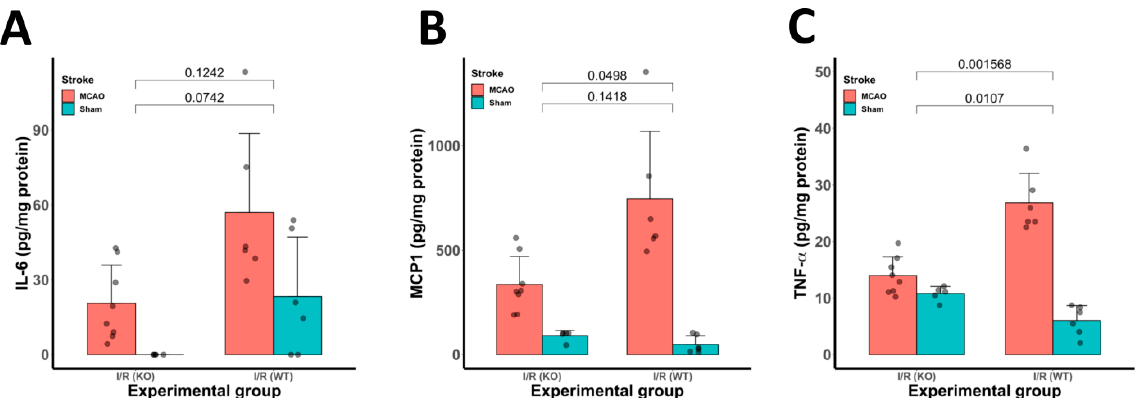
Figure 5. Inflammatory cytokine protein expression was reduced in CYP2E1( − / − ) mice following I/R (tMCAo) insult. Bar graphs show the protein concentration of ( A ) interleukin (IL)-6, ( B ) monocyte chemoattractant protein 1 (MCP-1), and ( C ) tumor necrosis factor (TNF)- α in brain tissues at 24 h of MCAo, measured by ELISA. CYP2E1( − / − ) groups show an almost two-fold reduction in inflammatory marker expression following I/R compared to WT I/R. Sham-operated animals did not show a marked increase in IL-6. The levels of brain IL-6, MCP1, and TNF- α were determined by ELISA kits. Data are presented as mean + SD, and n = 6–12.